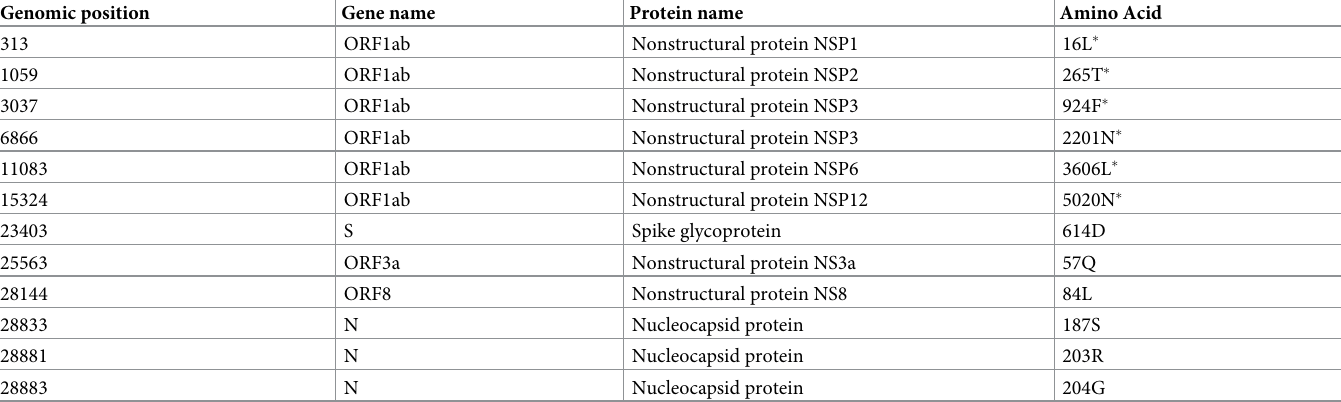
Table 1. Top 12 overlapping Genomic features and amino-acid changes obtained with the PFI and SHAP methods. ( � Amino acid position in ORF1ab polyprotein is provided). Genomic